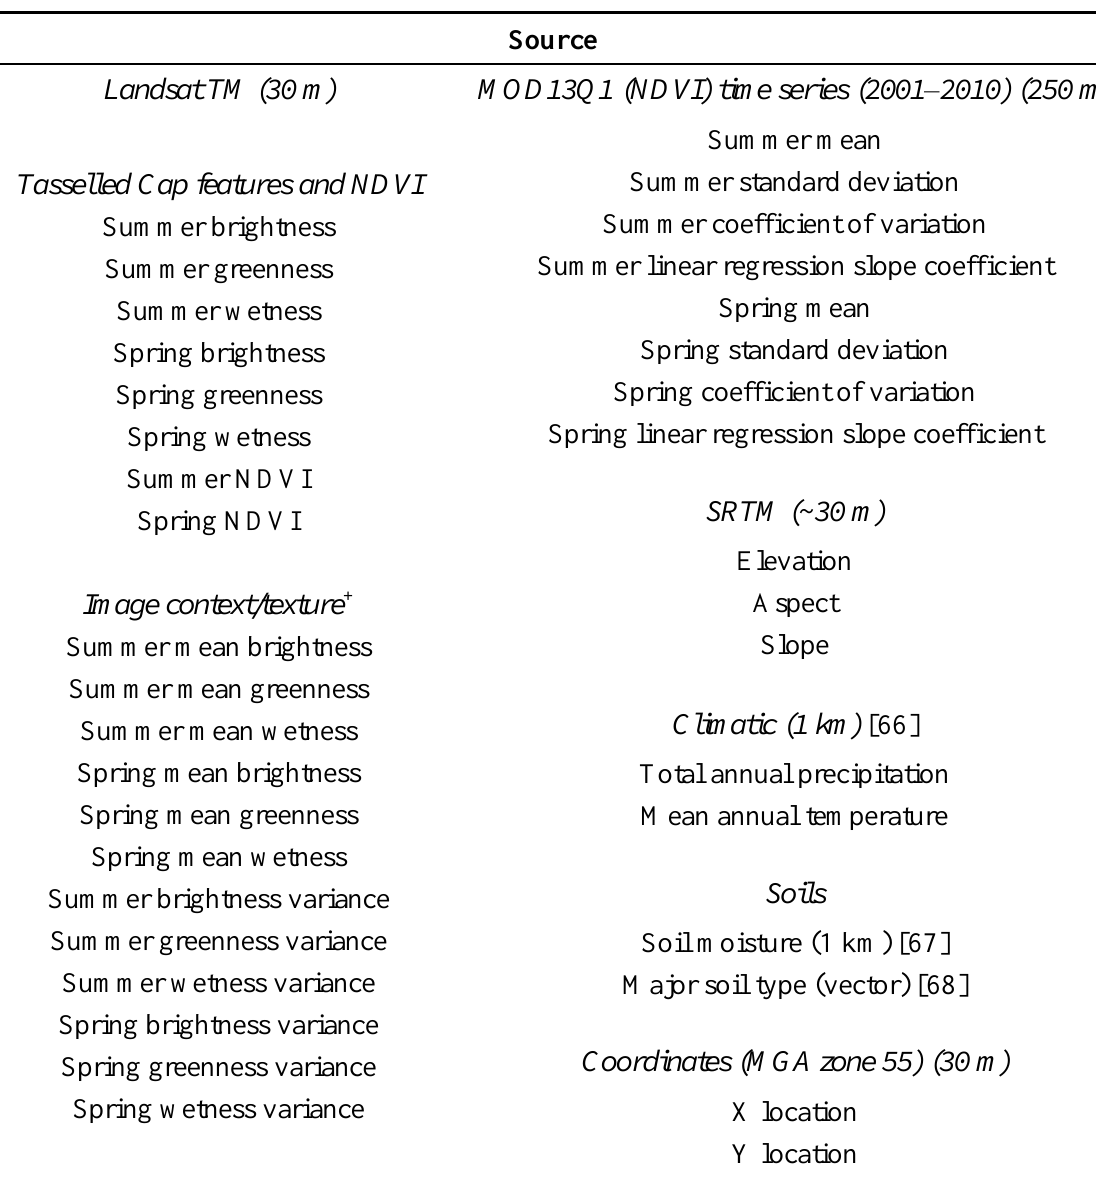
Table 2. List of predictor variables with original image resolution in brackets ( + kernel sizes: 3, 5, 15, 31, 65, and 99